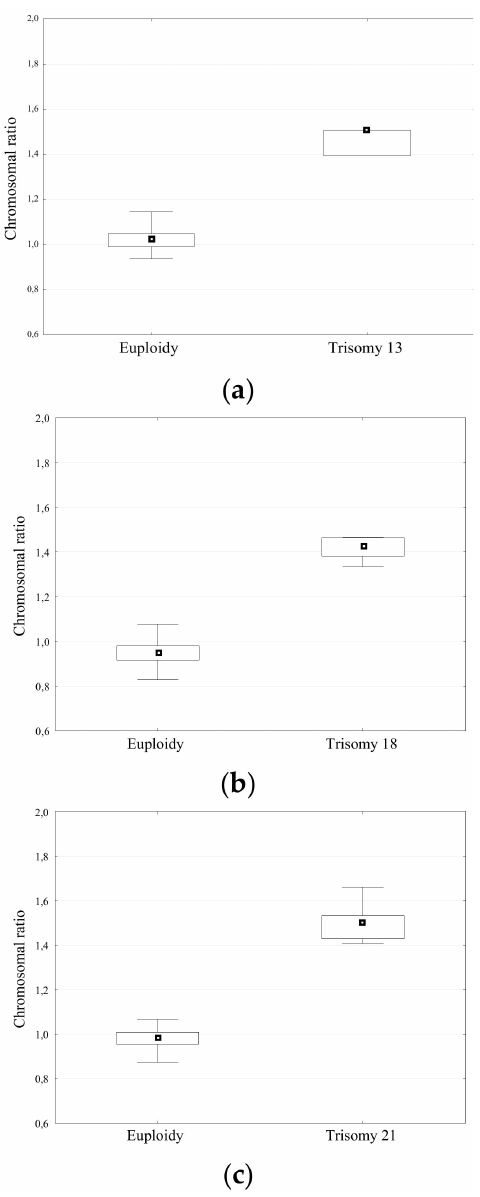
Figure 3. Box-and-whisker plots of the distribution of chromosome ratios in euploid and aneuploid samples. ( a ) Trisomy 13; ( b ) Trisomy 18 and ( c ) Trisomy 21. The boxes display the median (25th–75th percentiles) for the distribution; the whiskers represent the minimum and maximum value and the squares in the center of the plot represent the